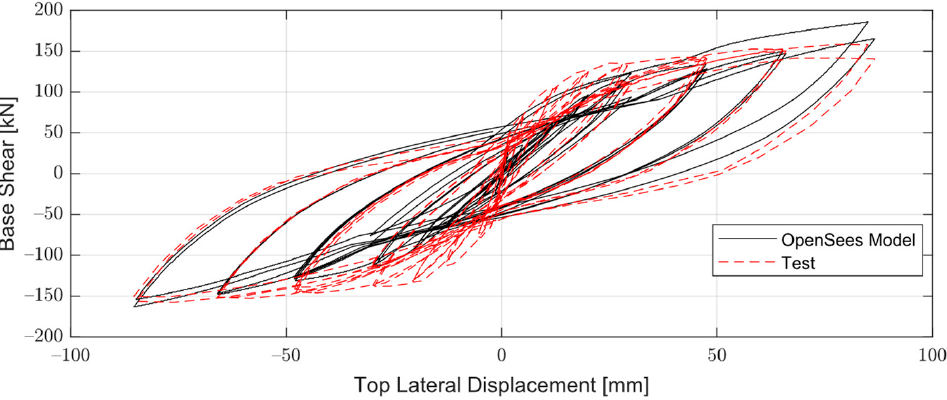
Figure 3. Base shear versus top lateral displacement in Specimen RW2 [21].